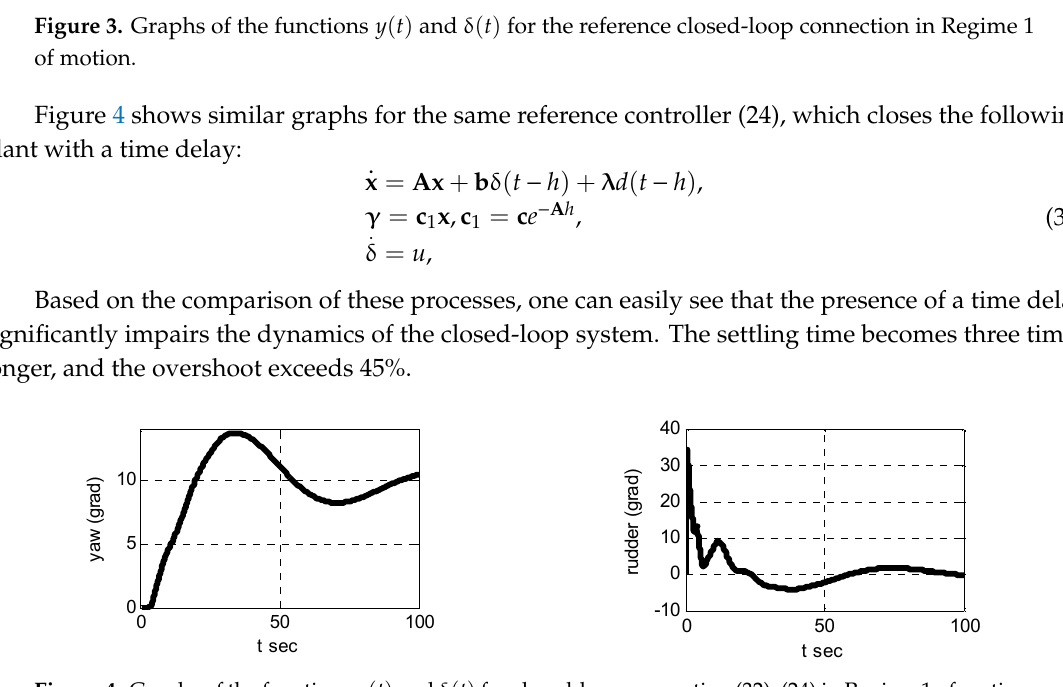
Figure 4. Graphs of the functions y ( t ) and δ ( t ) for closed-loop connection (32), (24) in Regime 1 of motion.